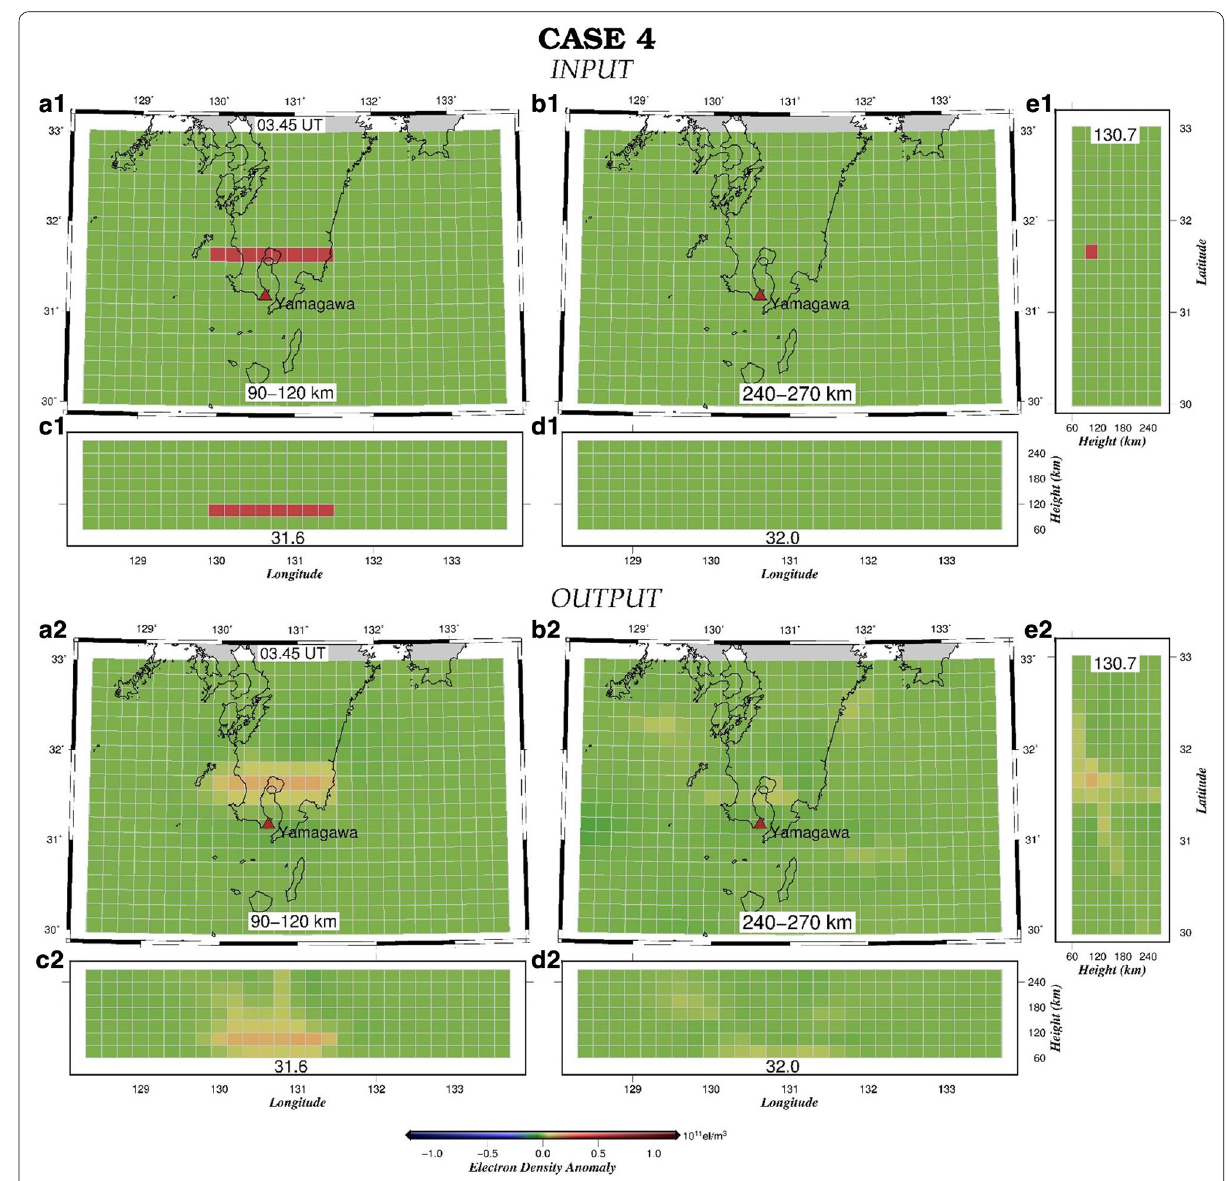
Fig. 5 Same as Fig. 4, but we assumed Case 4 in the Kyushu